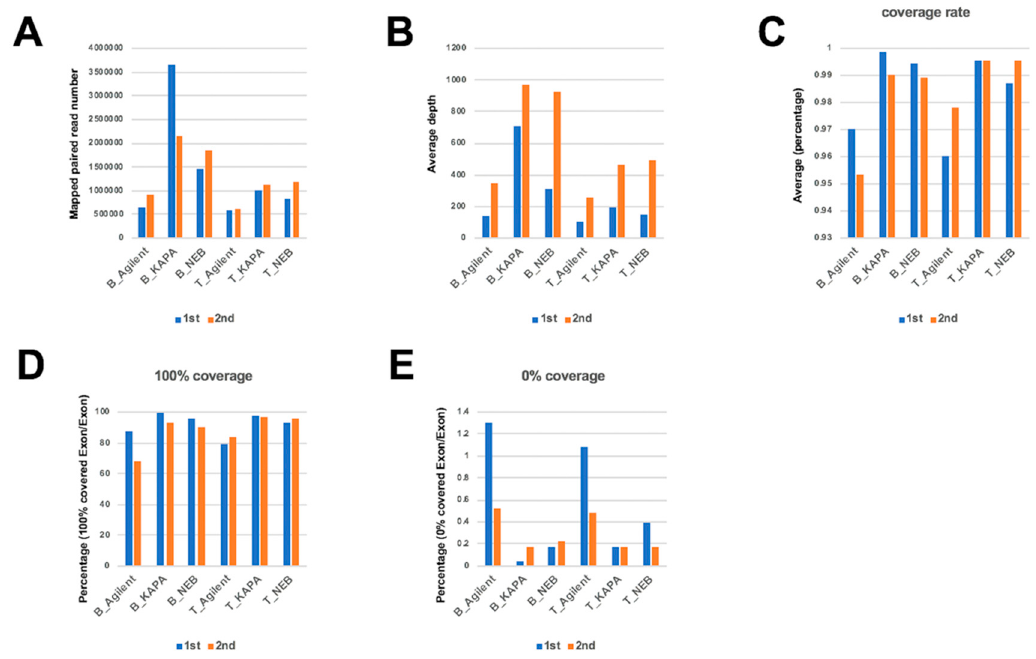
Figure 2. Comparison for dual deep sequencing. ( A ) The mapped read number for each sample. ( B ) The average depth was plotted for each polymerase in dual sequencing. ( C ) The average coverage rate percentages. ( D ) The percent of 100% coverage target regions. ( E ) The percentage of 0% coverage target regions. B: Blood sample T: Tumor sample